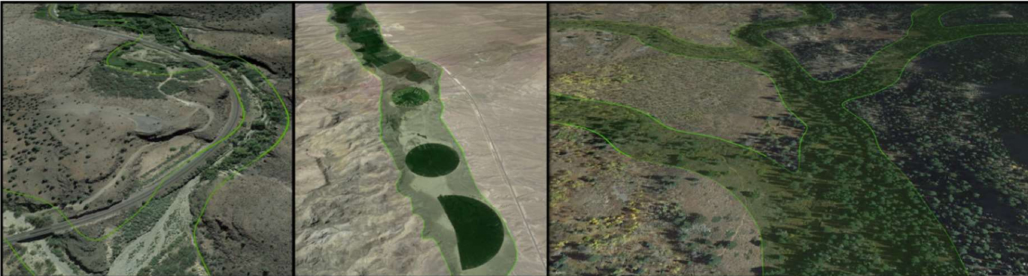
Figure 3. Example subsets of valley bottom extent results across three different environments. Green lines represent the external boundaries of the valley bottom, which we define as the riparian corridor. Vegetation outside of valley bottoms is considered to be outside of the riparian corridor. Within the valley bottom, riparian vegetation was separated from non-riparian vegetation such as agriculture (example in middle image) using riparian vegetation